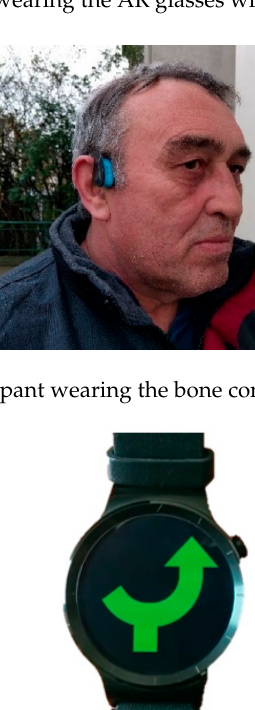
Figure 3. Smartwatch displaying an arrow.